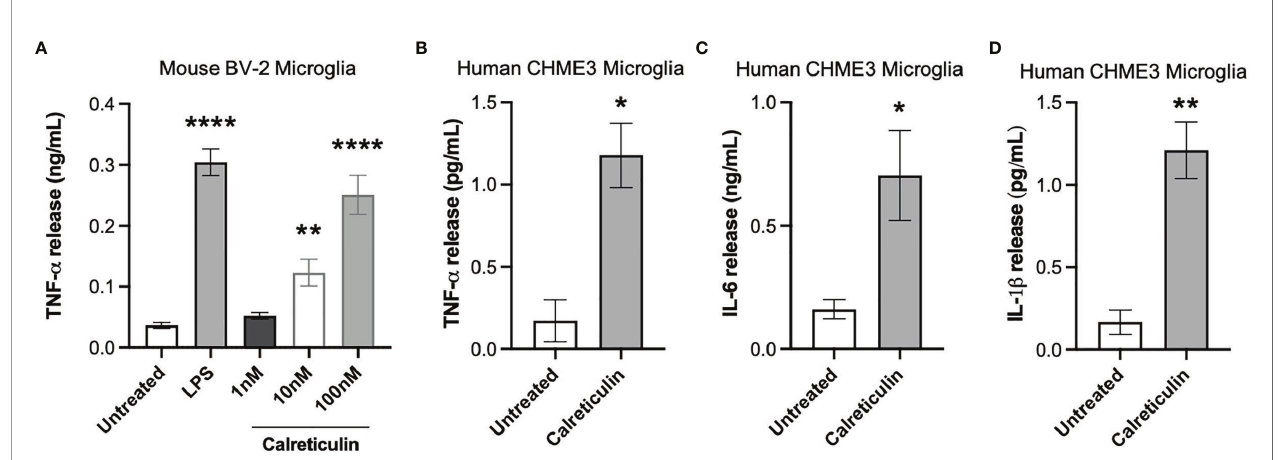
FIGURE 2 | Calreticulin induces cytokine release from mouse and human microglia. (A) BV-2 microglia were treated with lipopolysaccharide (LPS, 100 ng/mL) or human, recombinant calreticulin (1 nM, 10 nM or 100 nM) for 20 hours. Supernatants from treated BV-2 were assessed for TNF- a by ELISA. (B – D) CHME3 microglia were treated for 20 hours with 170 nM calreticulin (human, recombinant). Supernatants from treated CHME3 were assessed for (B) TNF- a , (C) IL-6 and (D) IL-1 b by meso scale discovery. Data presented as mean cytokine release values, with error bars representing the SEM of 3 independent experiments. Statistical comparisons were made to the untreated control by (A) one-way ANOVA and (B – D) unpaired t-test. *p<0.05, **p<0.01,